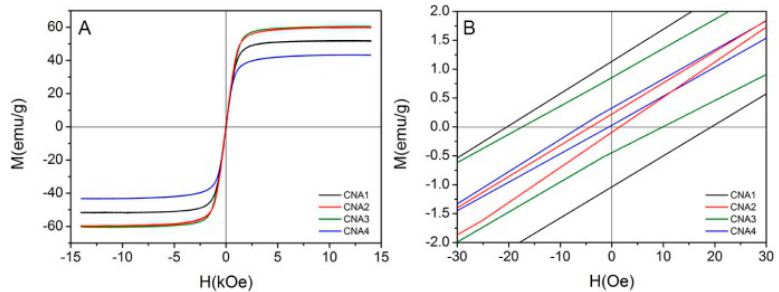
Figure 5. ( A ) Magnetization hysteresis curve of ZnFe 2 O 4 CNAs; and ( B ) the magnified graph of ( A ).